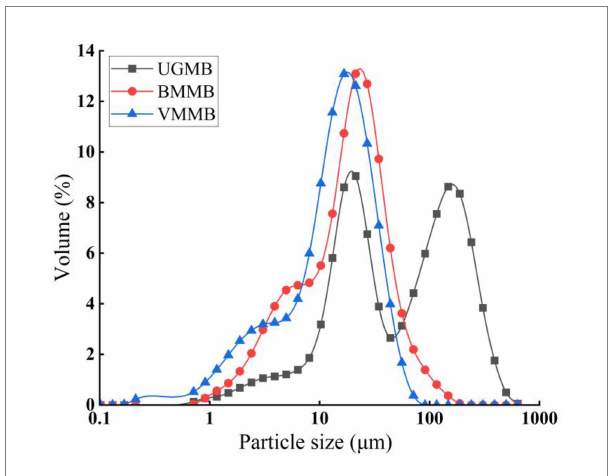
FIGURE 2 Particle size distribution by volume of mung bean flour.